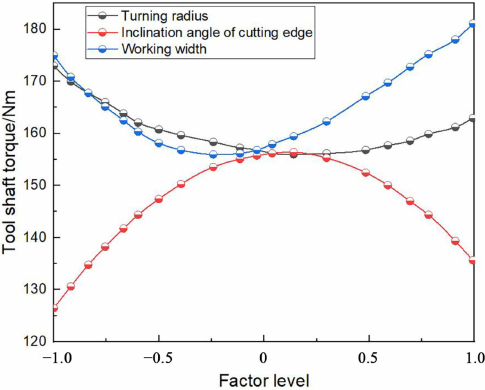
Figure 18. The relationship between each test factor and the tool shaft torque. Combined with tool shaft torque variance analysis, the test factors radius of gyration R , inclination angle of cutting edge β , and working width L interact with the tool shaft torque, as shown in Figure 19. P ( AB ) = 0.0159, P ( AC ) < 0.01 and P ( BC ) = 0.1124, indicating that ( AB ) and ( AC ) have an interactive effect on the test index tool shaft torque, which is consistent with the analysis of Table 7.